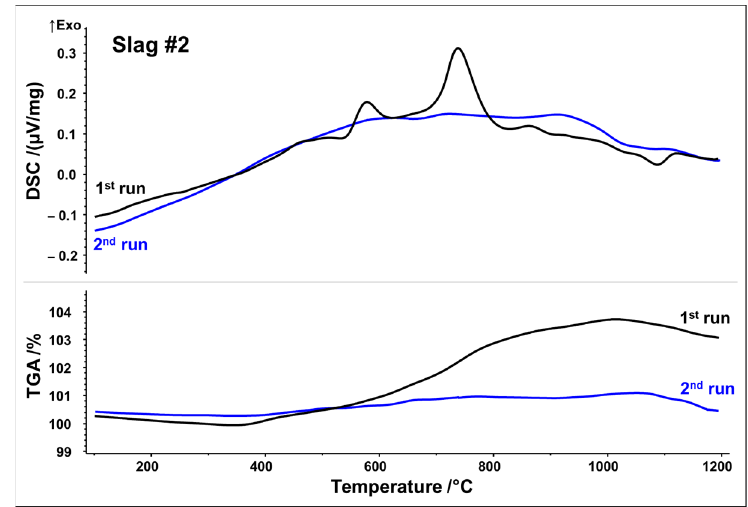
Figure 4. DSC/TGA analysis of slag 2; heating rate 10 K/min.